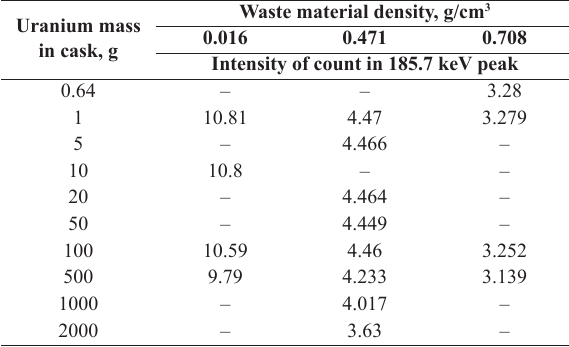
Table 4. Calculated intensities of the count in the 185.7 keV peak with the background deduction for different waste